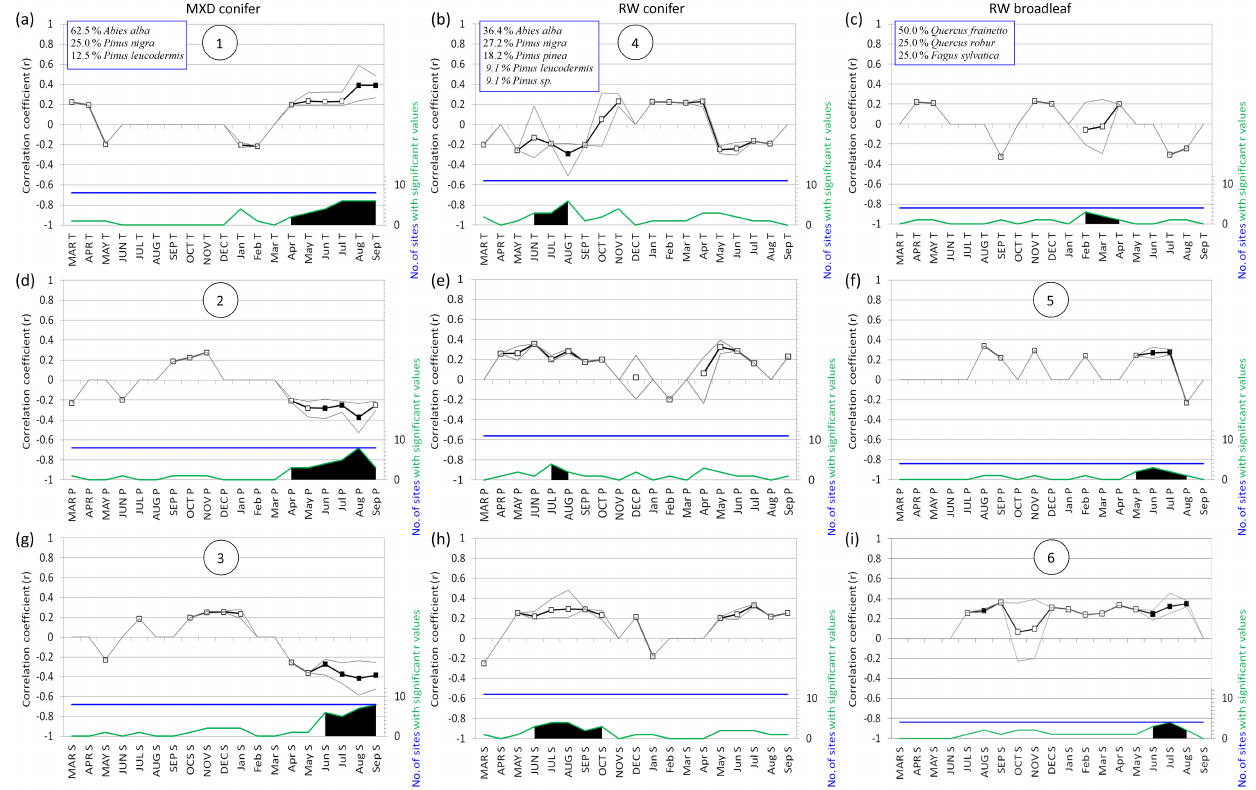
Figure 3. Bootstrapped correlation analysis performed over the common period of 1880–1980, considering chronologies of conifer MXD (left column; a, d, g ), of conifer RW (center; b, e, h ) and of broadleaf RW (right; c, f, i ) vs. monthly temperature (a, b, c) , precipitation (d, e, f) and SPI_3 (g, h, i) from March of the year prior to growth to September of the year of growth. In (a) , (b) , (c) the percentages of the species composing the pool for each site used for the analysis is reported. Means of statistically significant ( p <0.05) correlation coefficient values ( r ) are depicted with squares, whereas maximum and minimum significant r values are indicated with grey lines; the blue lines depict the total number of sites in each comparison and the green lines indicate the total number of sites with statistically significant r values. Black-filled squares are given for those variables that show significant correlation values for at least 50% of the total sites and have | r | >0.25; where both conditions occur, a circled number in the plot is given and the comparisons are selected for the following moving correlation analysis (Fig. 5). In each plot the climate variables with the highest number of sites with significant r values and nearby variables showing up to one-half of this number are depicted with a black